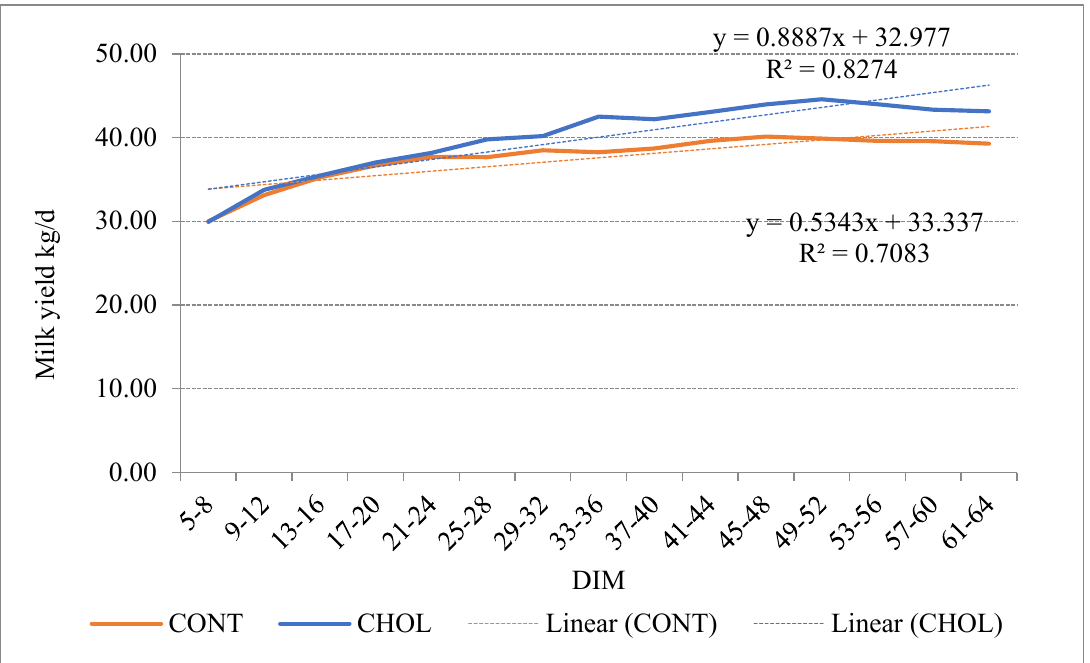
Figure 3. Changes in cows’ milk yield for the CHOL and CONT groups at different DIM intervals. The milk composition was different between the CHOL and CONT groups. In the period of 10–15 DIM, more fat was detected in the milk of the CHOL group (0.36%) ( p > 0.05) and 0.58% more for the period of 40–55 DIM than in the CONT group ( p < 0.05). The milk of the CHOL group contained less protein (0.09%) at 10–15 DIM and 0.23% more at the 40–55 DIM period than the CONT group ( p > 0.05). Furthermore, milk from the CHOL group had less SCC (45.83%) at 10–15 DIM and 8.2% more at 40–55 DIM than the CONT group, with p > 0.05 (Figure 4).